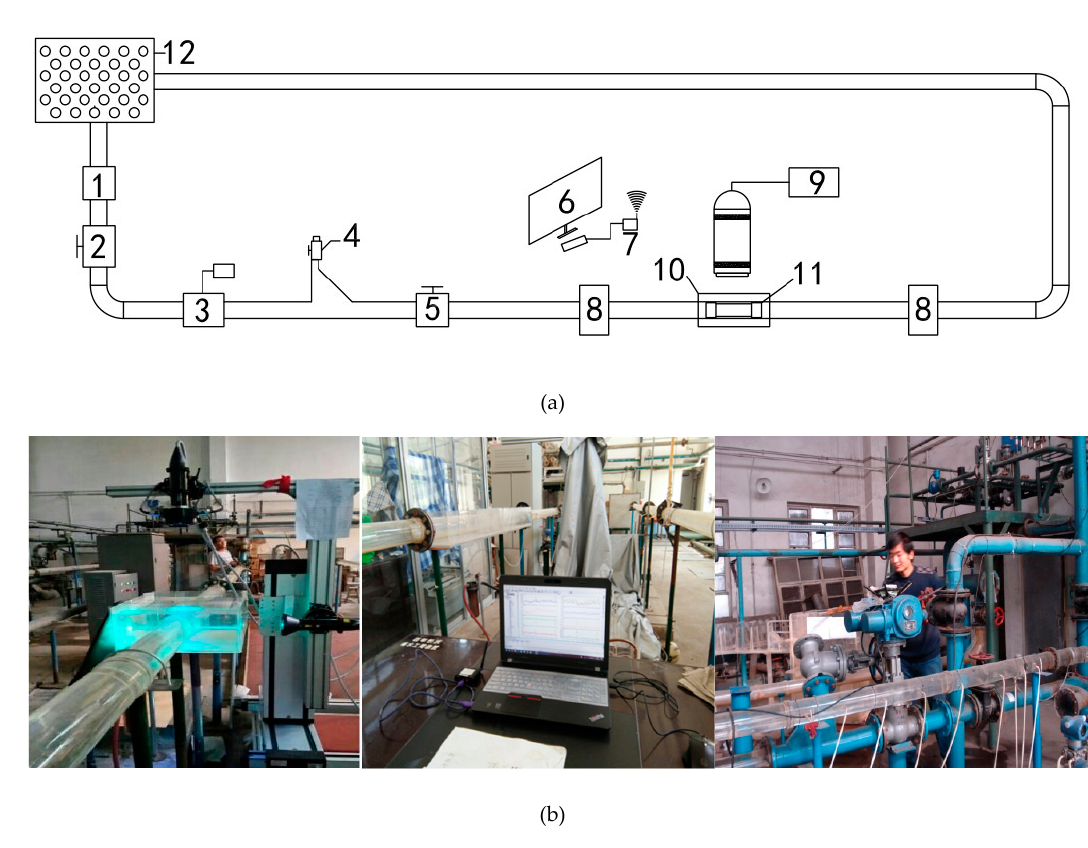
Figure 2. Experimental system device: ( a ) schematic diagram: 1. centrifugal pump; 2. regulating valve; 3. turbine flow meter; 4. the capsule delivery device; 5. brake device; 6. computer; 7. flow velocity receiving device; 8. the photoelectric sensor; 9. phase doppler analyzer (PDA); 10. rectangular water jacket; 11. capsule; and 12. the water supply device and the capsule receiving device. ( b ) Physical diagram.